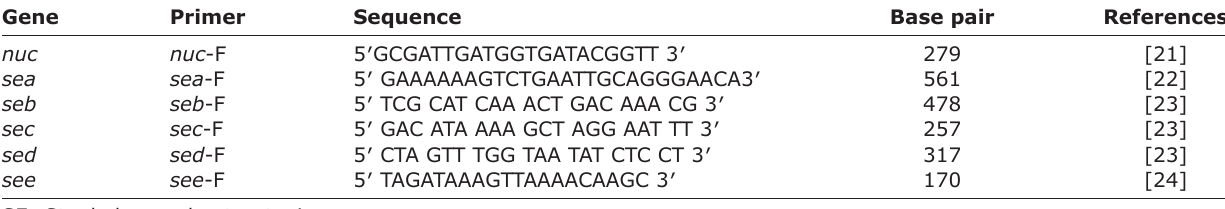
Table-1: Primers used for the detection of Staphylococcus aureus (SE) genes.